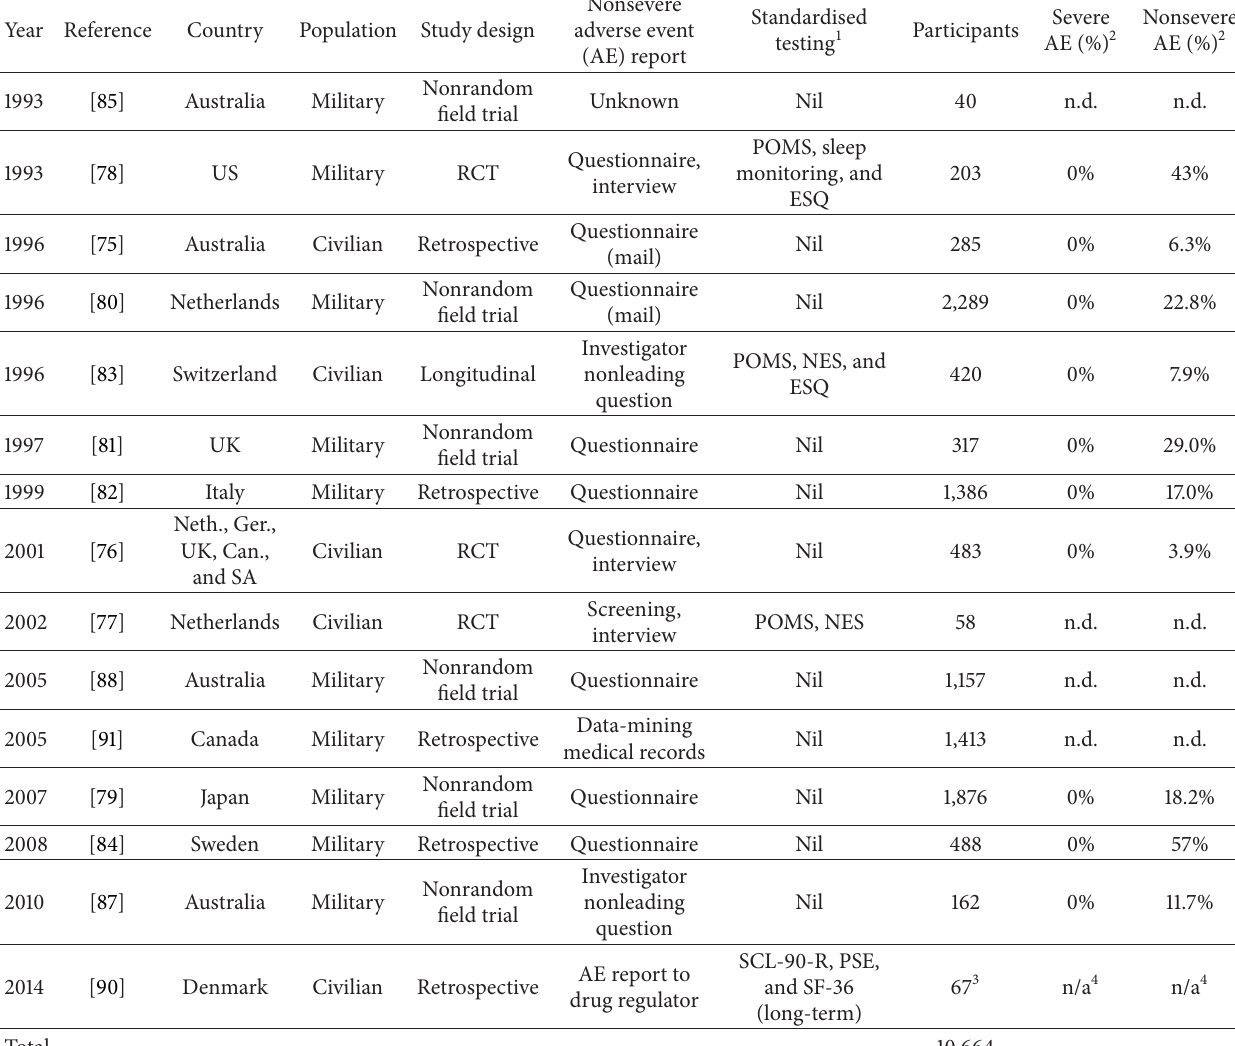
Table 1: Summary of selected pharmacoepidemiological studies relating to mefloquine prophylaxis safety and